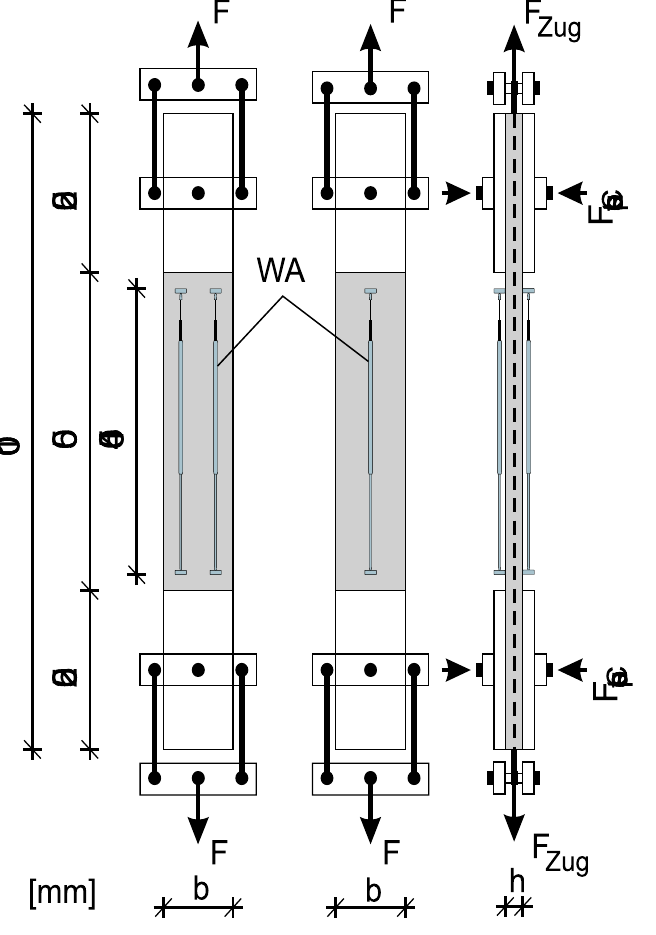
Figure 2. Schematic representation of the uniaxial tensile test on textile-reinforced concrete members 15